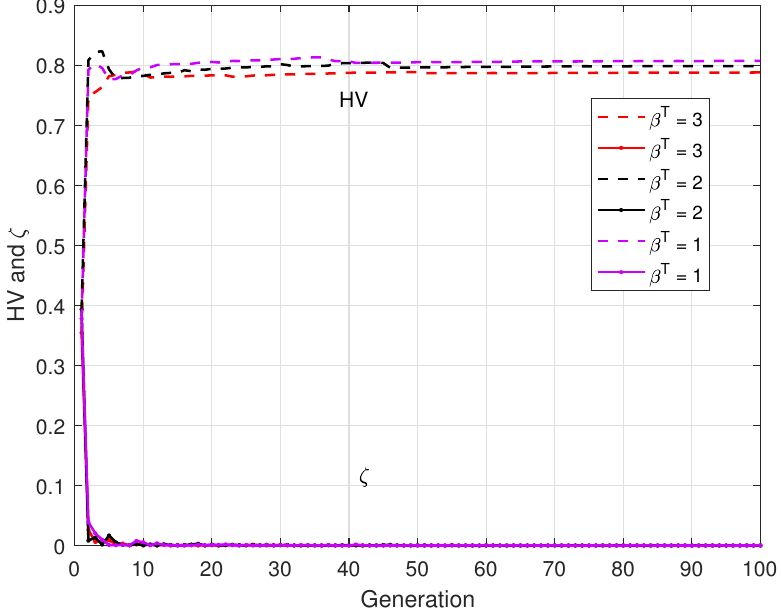
Figure 3. Progress of hypervolume and ζ of SLMDE with respect to number of generations for example